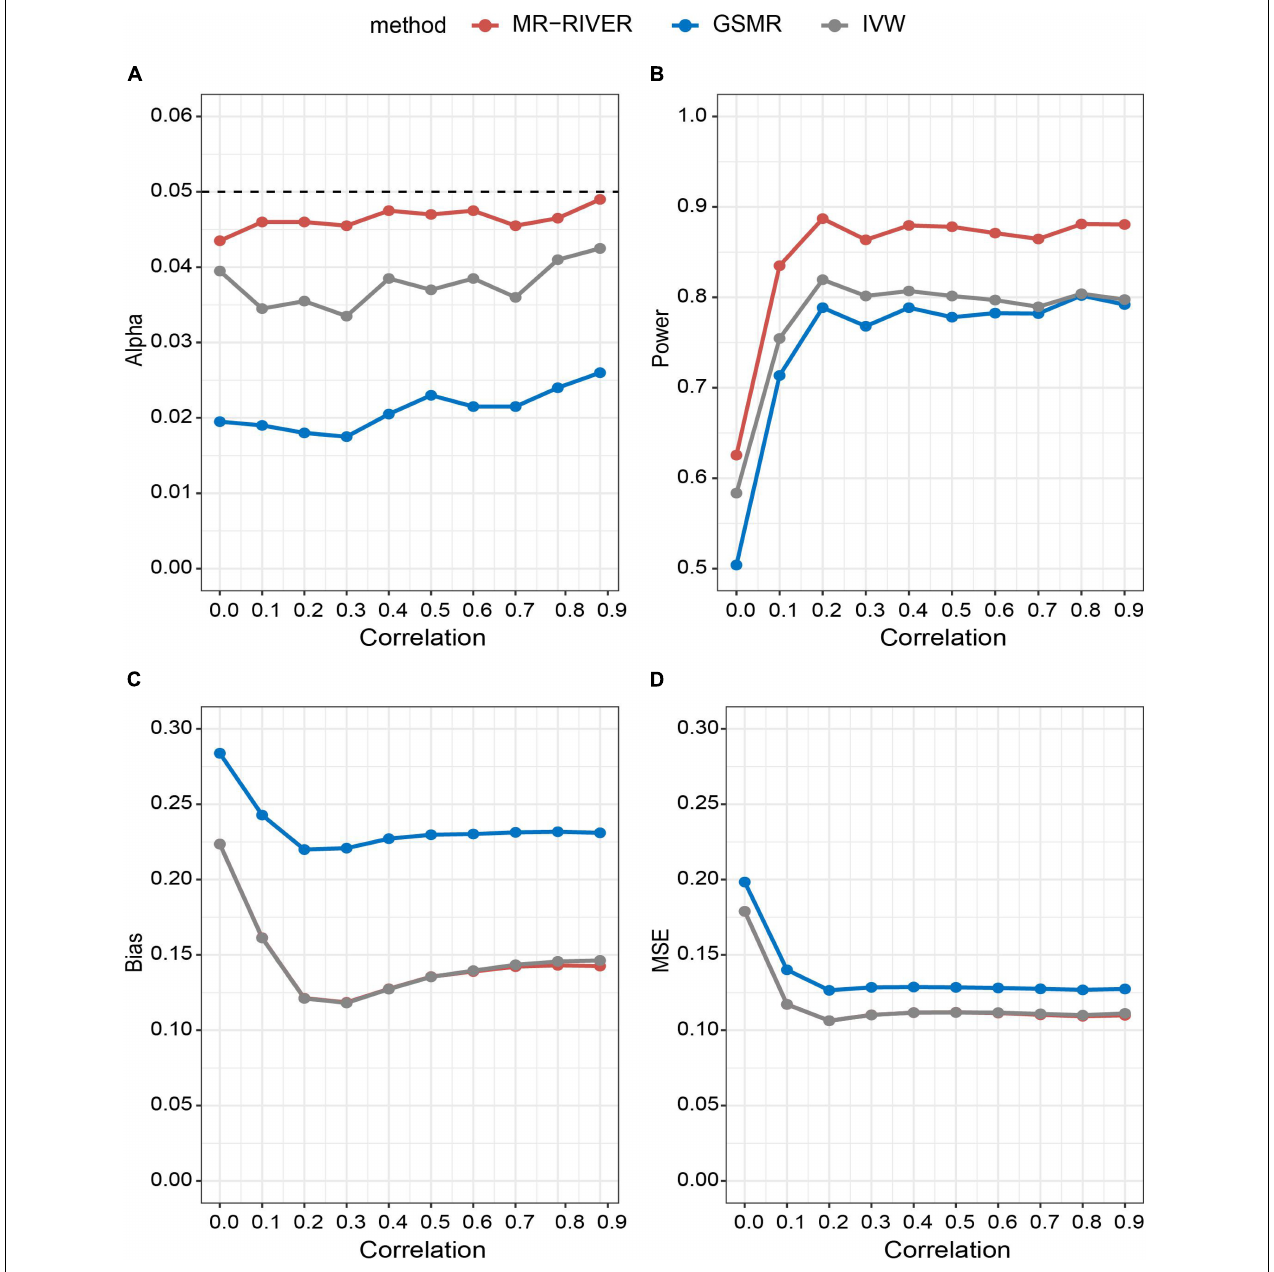
FIGURE 4 | Statistical properties of MR methods under different correlations. Correlation between IVs plotted against: (A) type I error under the null hypothesis; (B) performance of power under the alternative hypothesis with b xy = 1; (C) bias under the alternative hypothesis; and (D) mean square